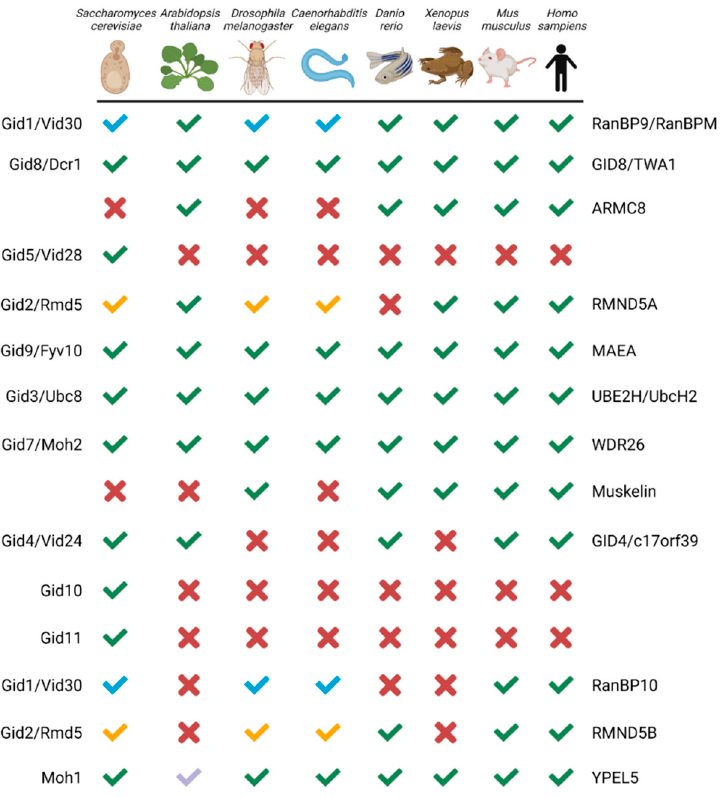
Figure 1. GID/CTLH subunits from yeast to human. Green checkmark or X indicates an orthologue is present or absent, respectively. Paralogues which map to the same gene have a colour-coded checkmark: blue for RanBP9/RanBP10 and yellow for RMND5A/RMND5B. For YPEL5, the light blue checkmark indicates Yipee-like proteins co-purified with RanBPM in Arabidopsis thaliana . The yeast and human protein names are indicated on the left and right, respectively. Created with Biorender.com (accessed on 21 April